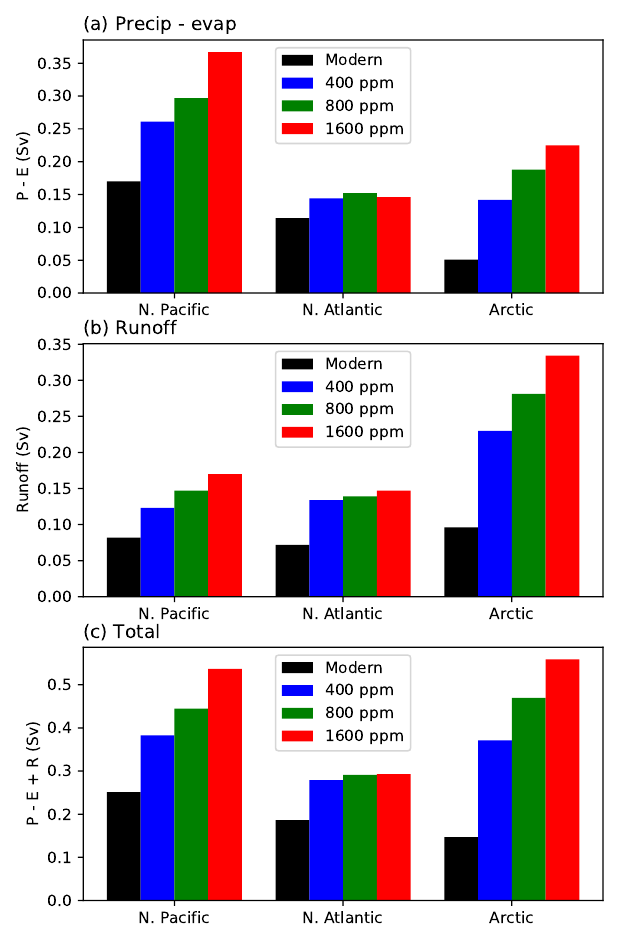
Figure 13. (a) Precipitation minus evaporation into the North Pa- cific and North Atlantic (both with a cut-off latitude of 45 ◦ N) and the Arctic Ocean, comparing a modern CM2.1 simulation with the late Eocene model at 400, 800 and 1600ppm. (b) River run-off with the same breakdown as in (a) . (c) The total of precipitation minus evaporation plus